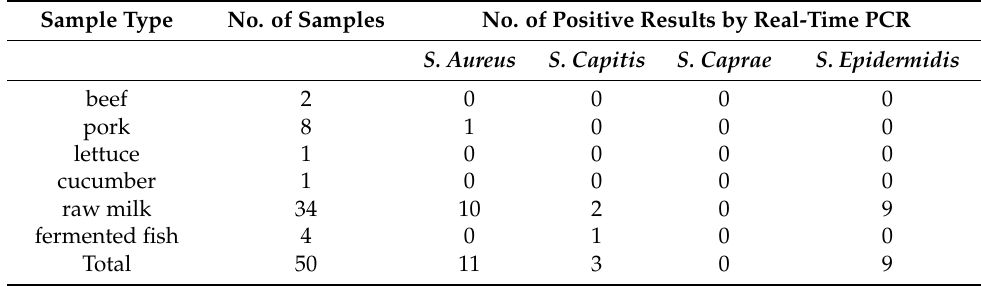
Table 4. Identification of Staphylococcus contamination in food samples using the real-time PCR method developed in this